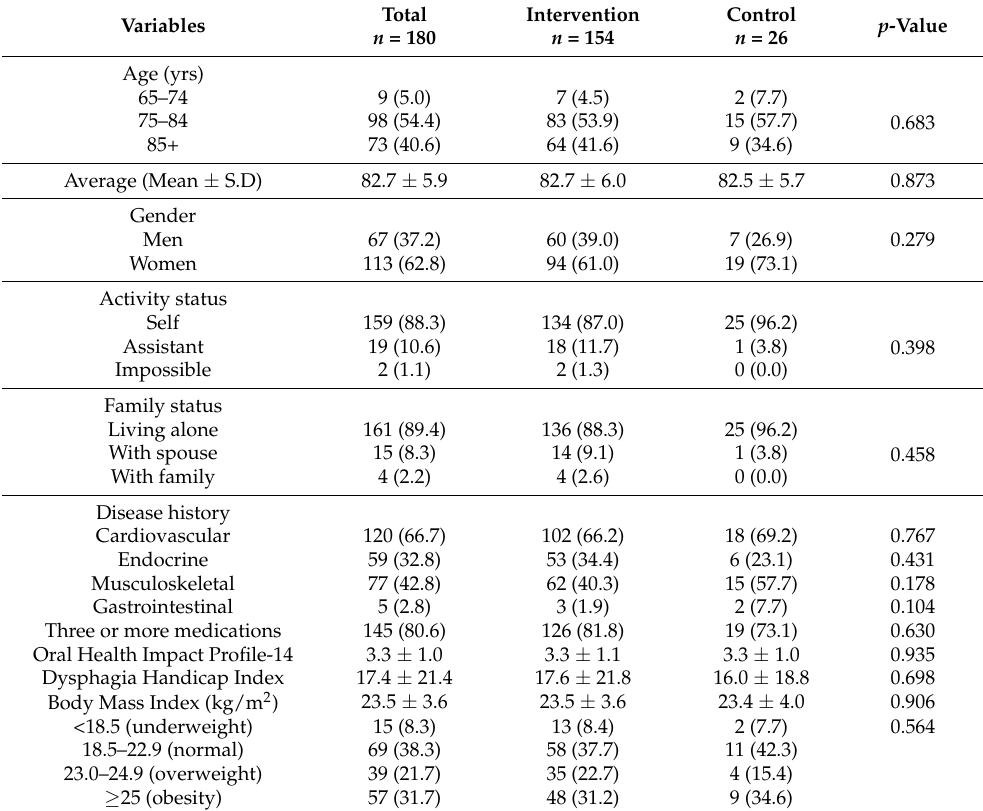
Table 1. General characteristics of participants in the